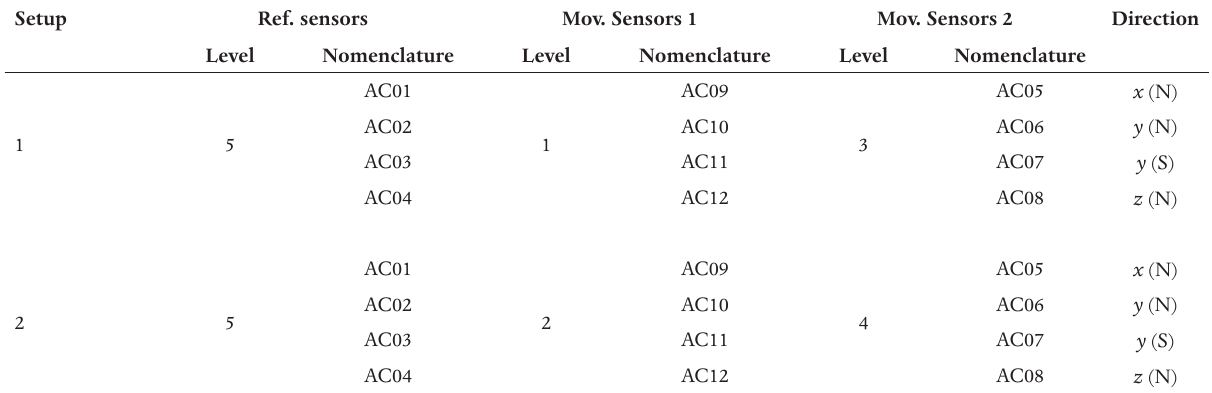
Table 1. Detailed list of reference and moving sensors used for the dynamic identification. Before After Before After Mode